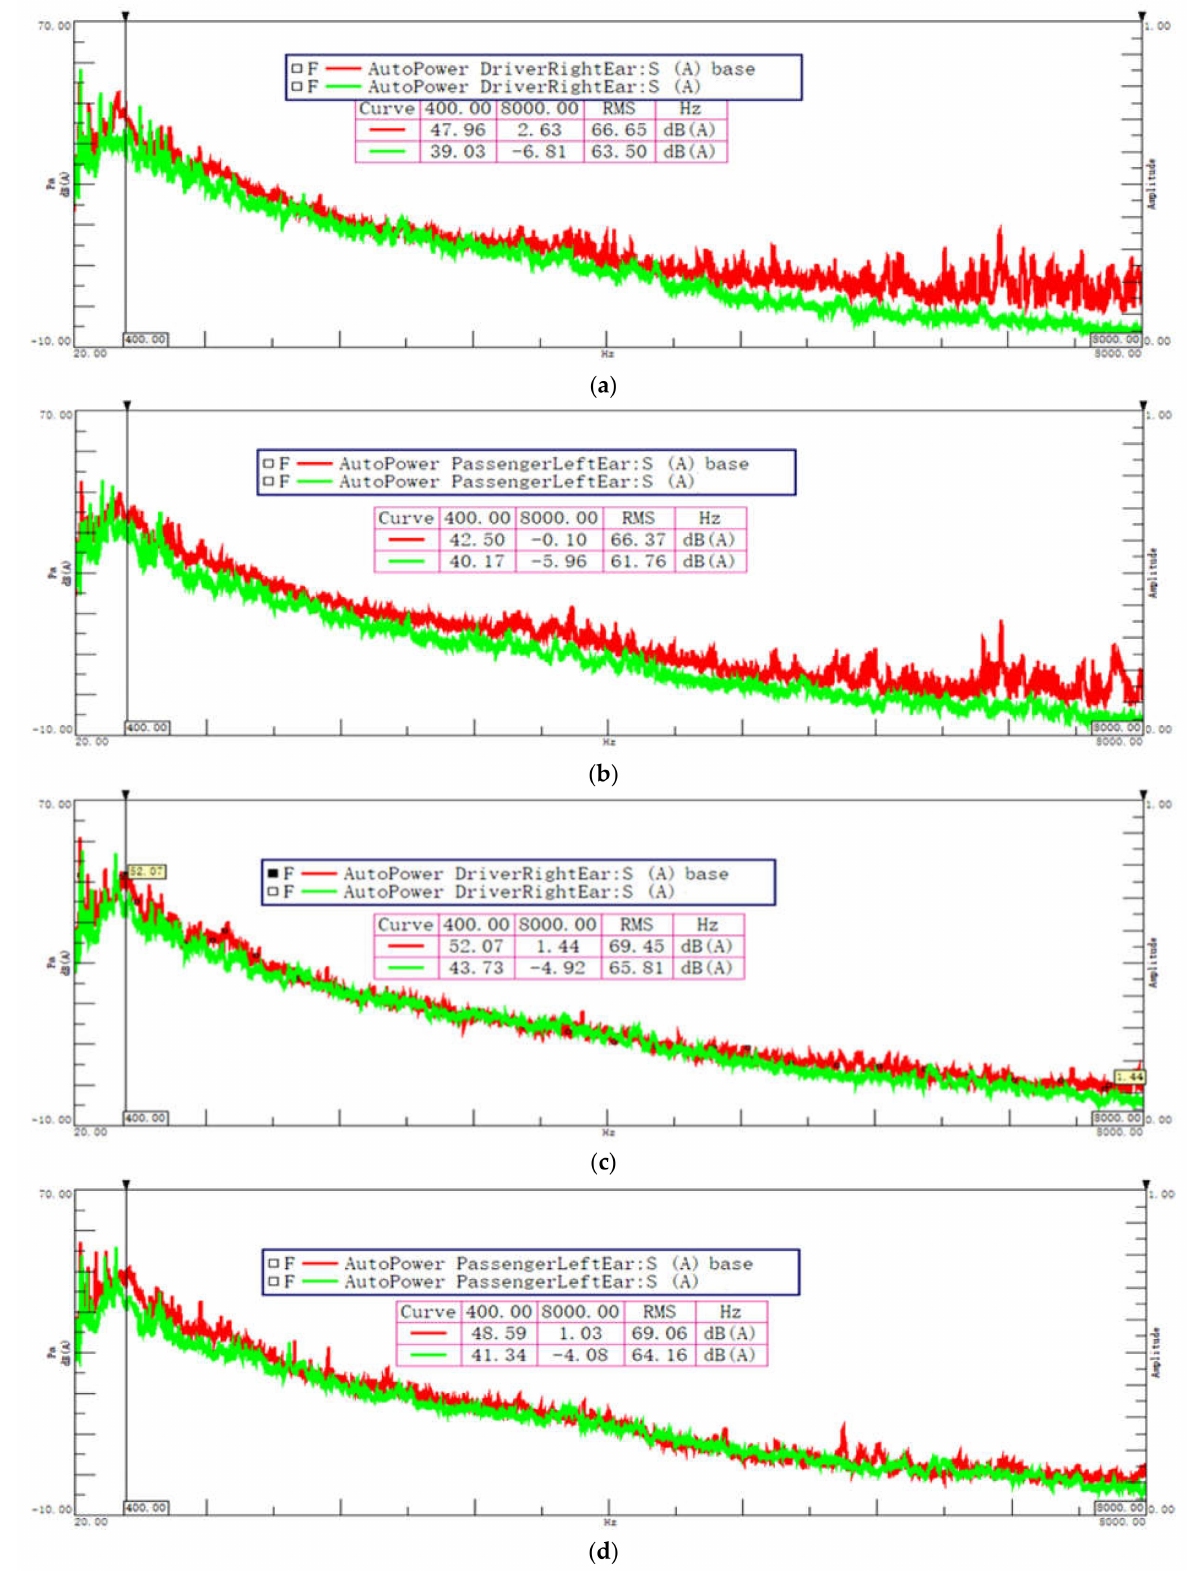
Figure 19. Optimization of acoustic performance under typical no-load conditions. ( a ) 70 km/h uniform no-load condition, comparison before and after optimization of main drive noise; ( b ) 70 km/h uniform no-load condition, comparison before and after optimization of first drive noise; ( c ) 80 km/h uniform no-load condition, comparison before and after optimization of first drive noise; ( d ) 80 km/h uniform no-load condition, comparison before and after optimization of first drive